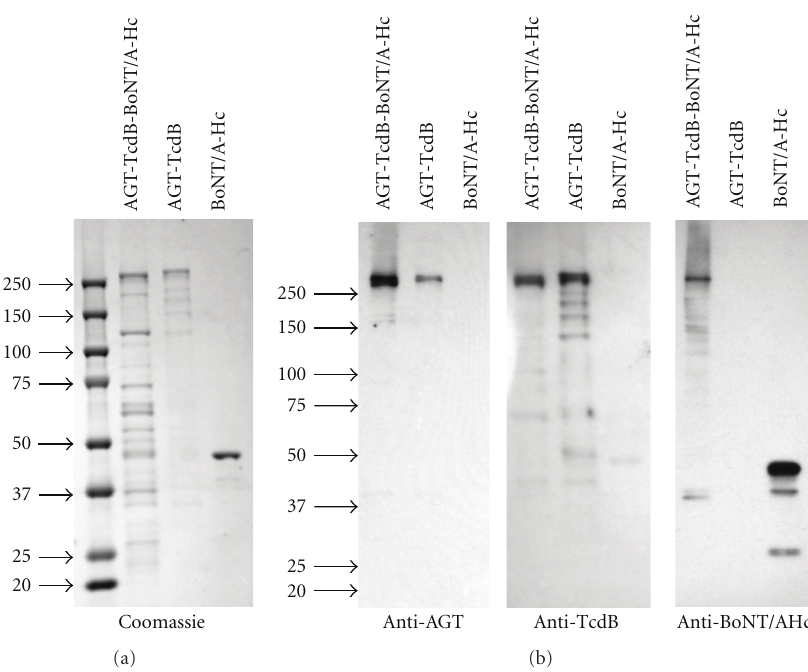
Figure 4: Recombinant expression of TcdB with a BoNT/A RBD. Recombinant AGT-TcdB, AGT-TcdB-BoNT/A-Hc, and BoNT/A-Hc were expressed and purified. (a) Each preparation containing 250 ng of protein was analyzed by SDS-PAGE and protein stain. (b) The preparations were also analyzed by Western blots using anti-AGT serum, anti-TcdB serum, or anti-BoNT/A-Hc mAb as indicated. The position of molecular weight markers is indicated with